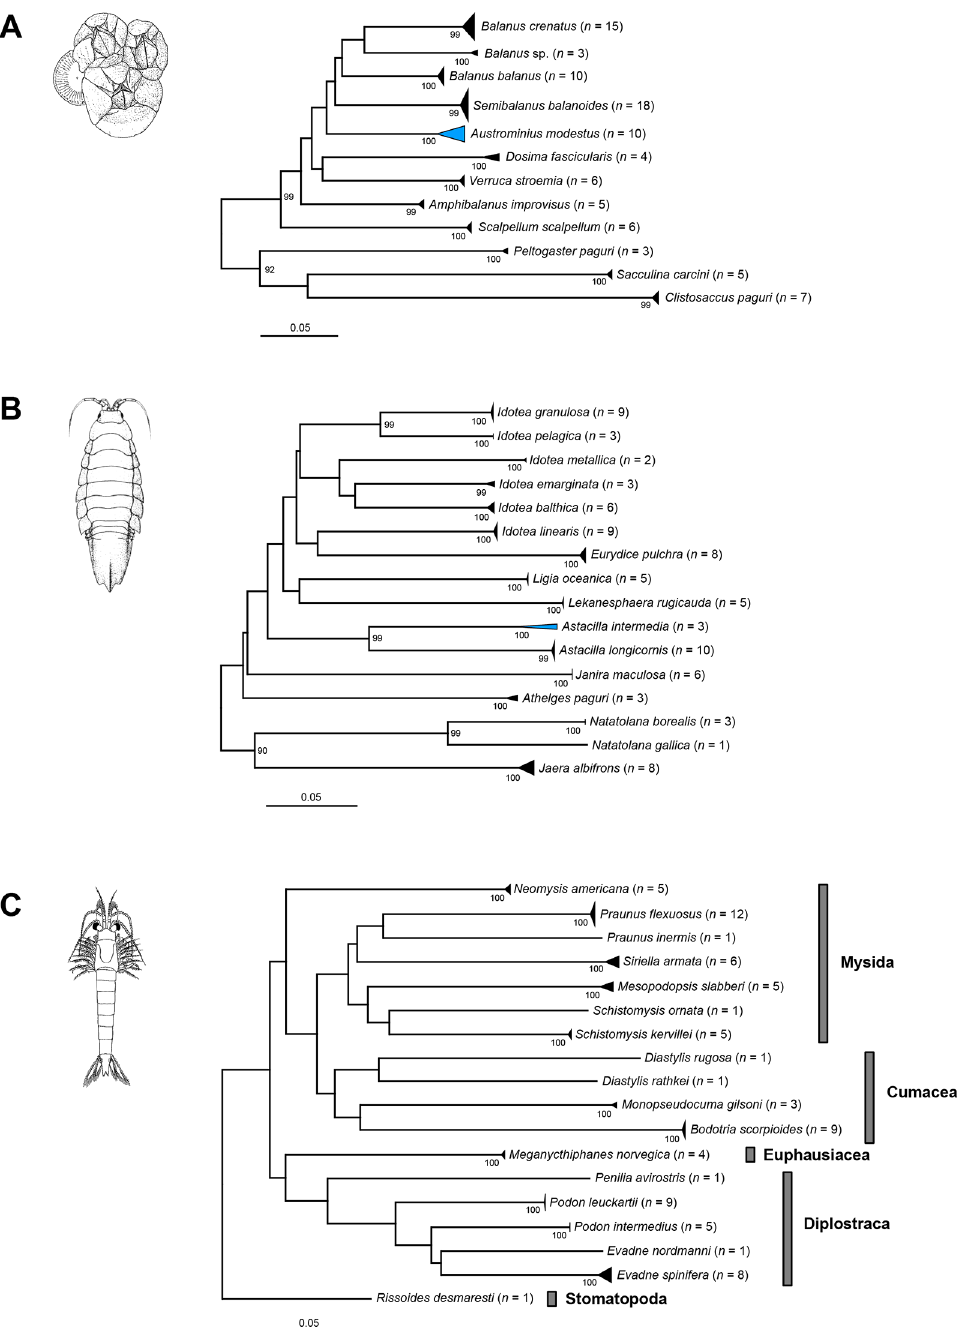
Fig 4. Neighbor joining topologies of various crustacean taxa based on Kimura 2-parameter distances. The number of analyzed specimens collapsed into a single node is provided following the species name. Triangles indicate the relative number of individual ’ s sampled (height) and sequence divergence (width). Blue triangles indicate species with intraspecific maximum pairwise distances > 2.2%. Numbers next to nodes represent non-parametric bootstrap values > 90% (1,000 replicates). Drawings of species are taken and modified from previous publications ( Balanus crenatus Brugui è re, 1789 (A) and